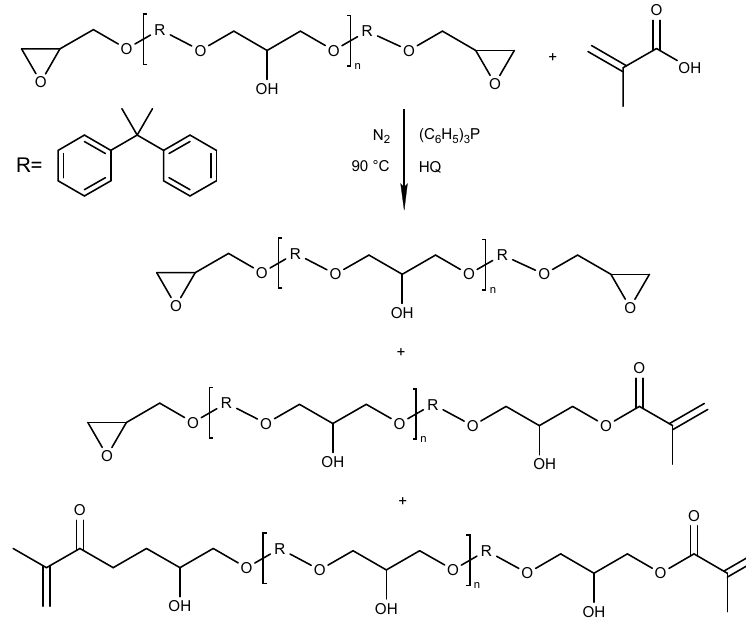
Figure 9. Synthesis of epoxy methacrylate resin.